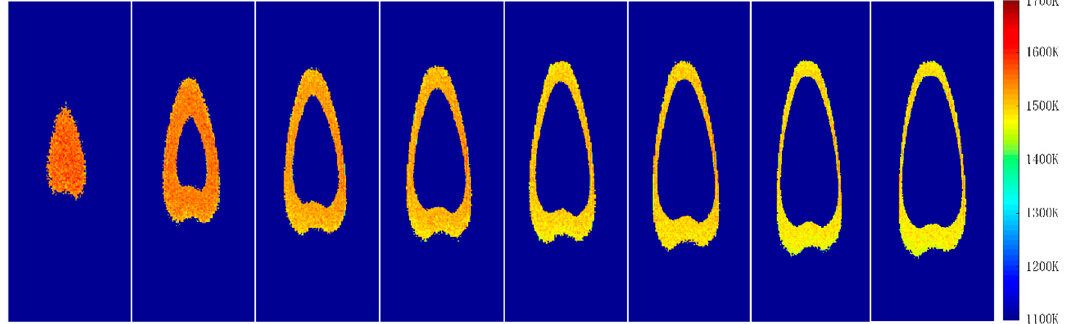
8 of 12 Figure 5. Original flame images. Figure 6 is the temperature distribution of the original flame image in Figure 5, calculated by the method described in Section 4.1. It is obvious that the contour of the temperature distribution has the same variation tendency with the original flame image, and the temperature range of the flame is between 1300 K and 1600 K, approximately. From the eight pictures, only the first one, which used the exposure time of 20 μ s, has the highest temperature in the flame center, while in the other seven pictures the central temperatures are all lower than the surrounding part. The reason is that with the increment of the exposure in those seven cases, the flame became brighter in the center and the gray values of R and G in the central part became saturated gradually, which led to an inaccurate temperature calculation. Figure 6. Original temperature distributions. Thus, the multi-exposure time image fusion method presented in Section 2.2 will be applied